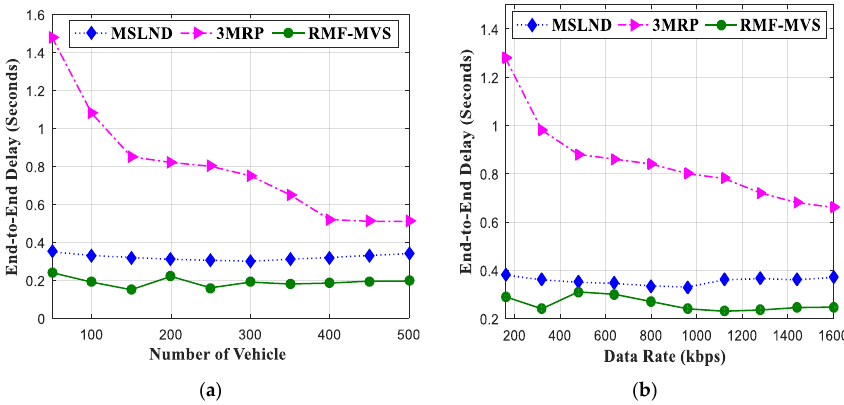
Figure 8. Delay (E2ED) Results Based on Different Number of ( a ) Vehicles and ( b ) Data Rates.